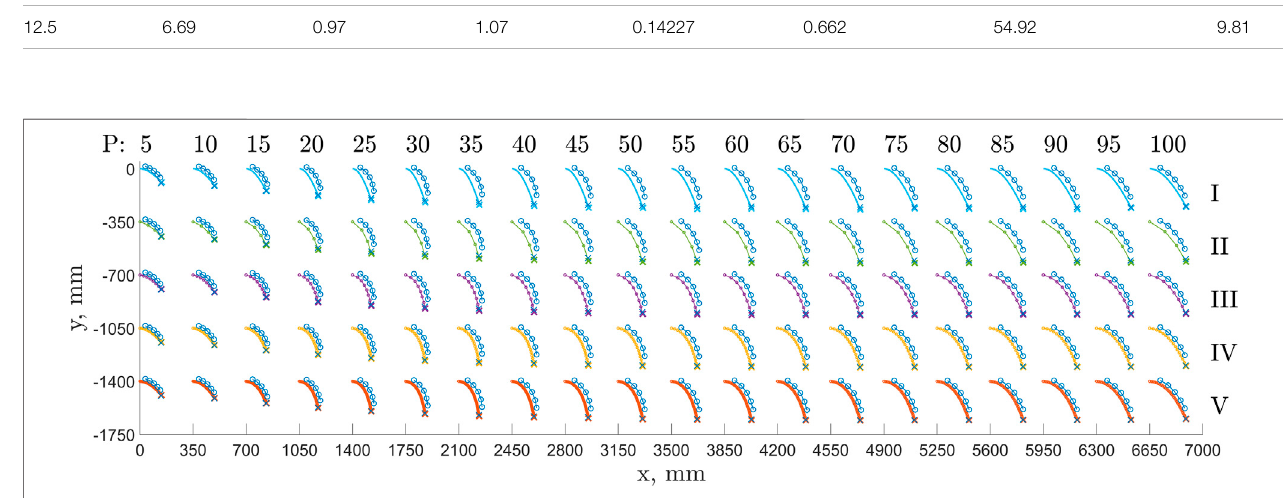
FIGURE7| The fi gureshowsmodeledbeamshapesfor:theEuler-Bernoullimodel(color:brightblue,row:I),the4-nodePDERmodel(green,II),the8-nodePDER model (purple, III), the 16-node PDER model (yellow, IV), the 32-node PDER model (red, V) for a range of internal pressures. The internal pressure ranges: (A) P = (5, 10, ... , 50)psi (B) P = (55, 60, ... ,